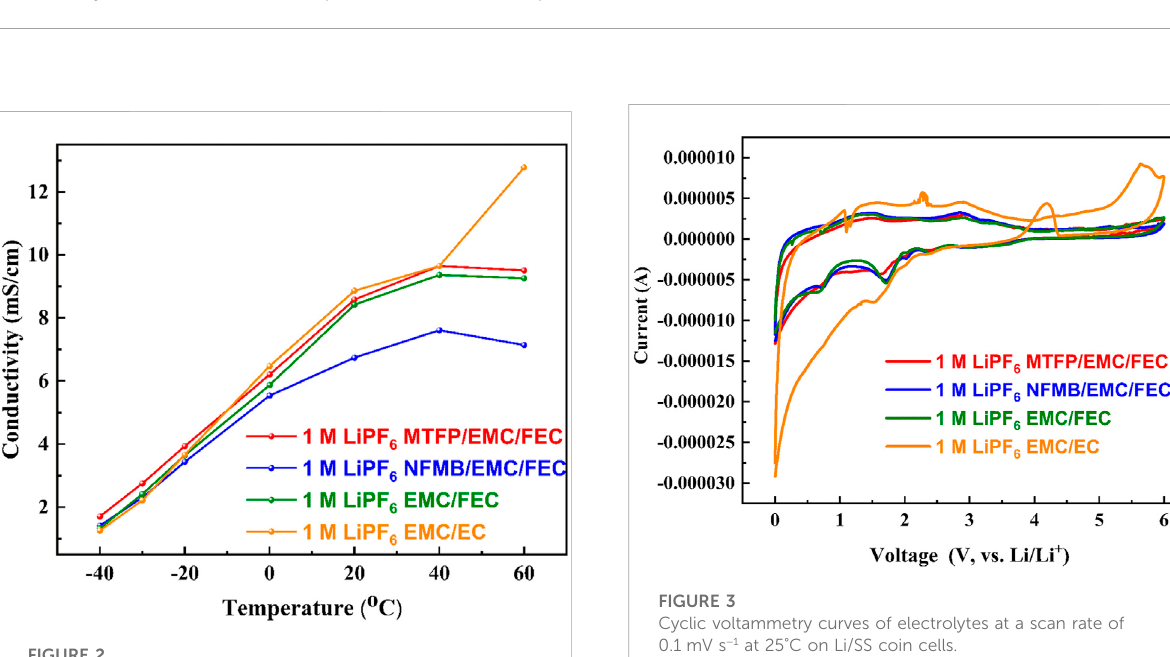
FIGURE 1 Reactivity of lithium metal sheet and pure solvents at room temperature.